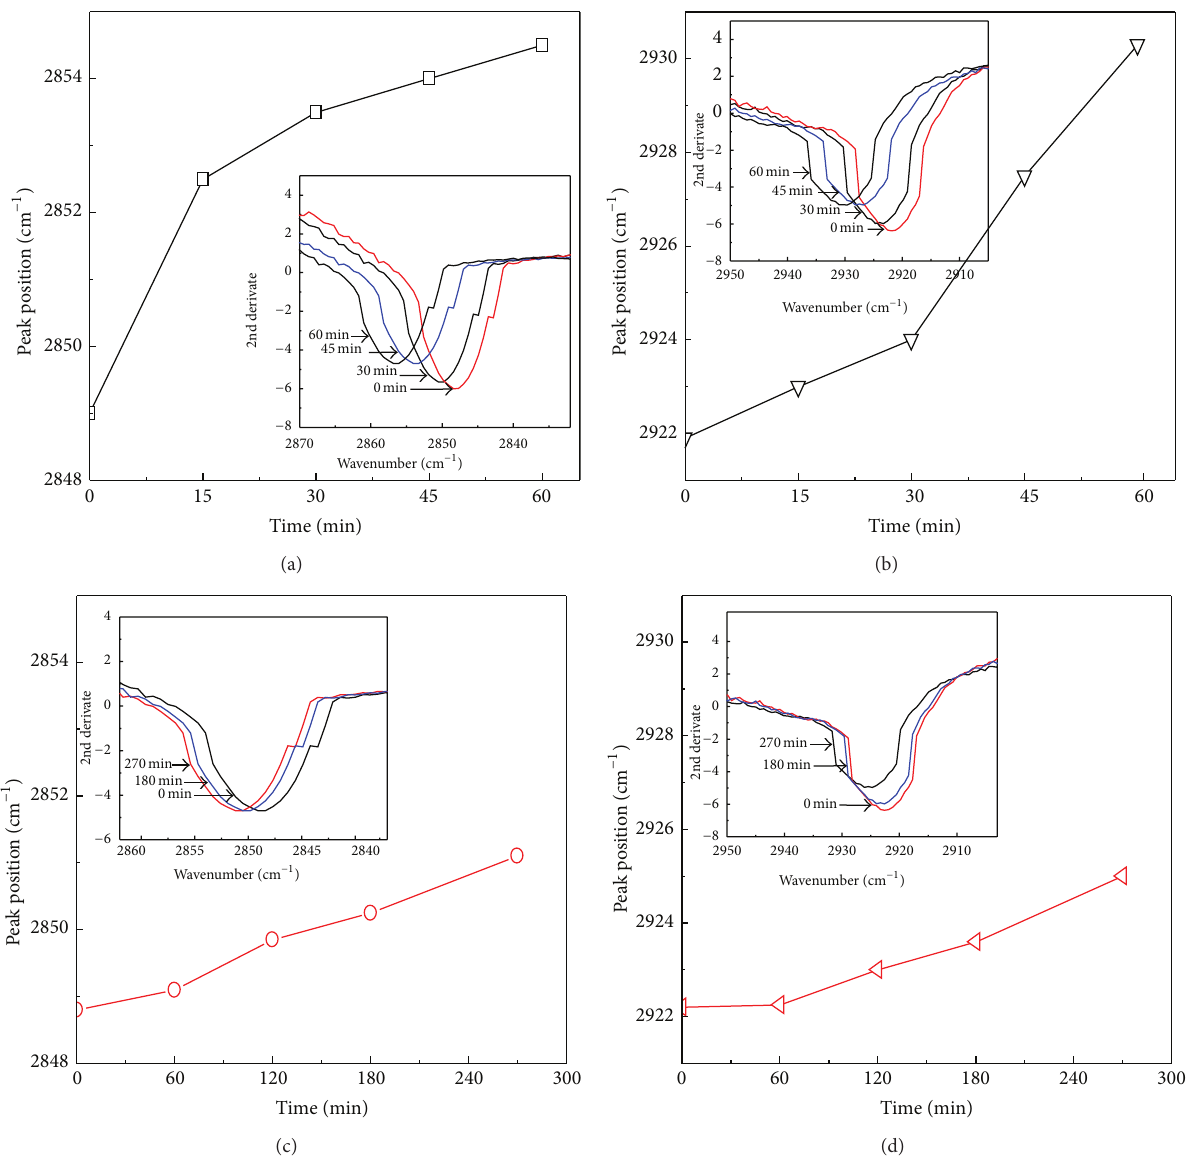
Figure 5: Shift of the stretching vibrations as a function of time detected by ATR-FTIR for the asymmetric ] 𝑎 (CH 2 ) vibrational bands and the symmetric ] 𝑠 (CH 2 ) vibrational bands for E. coli up to 60 min under solar simulated irradiation. (a) and (b) show the shifts of ] 𝑎 (CH 2 ) vibrational bands on PE-TiO 2 samples pretreated with RF air plasma for 15 min and then sputtered for 8min. (c) and (d) show the IR shifts of ] 𝑠 (CH 2 ) vibrational bands on nonpretreated PE-sputtered for 8